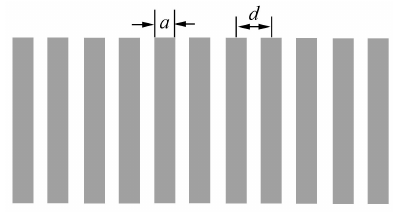
Figure 3. One-dimensional rectangular array.